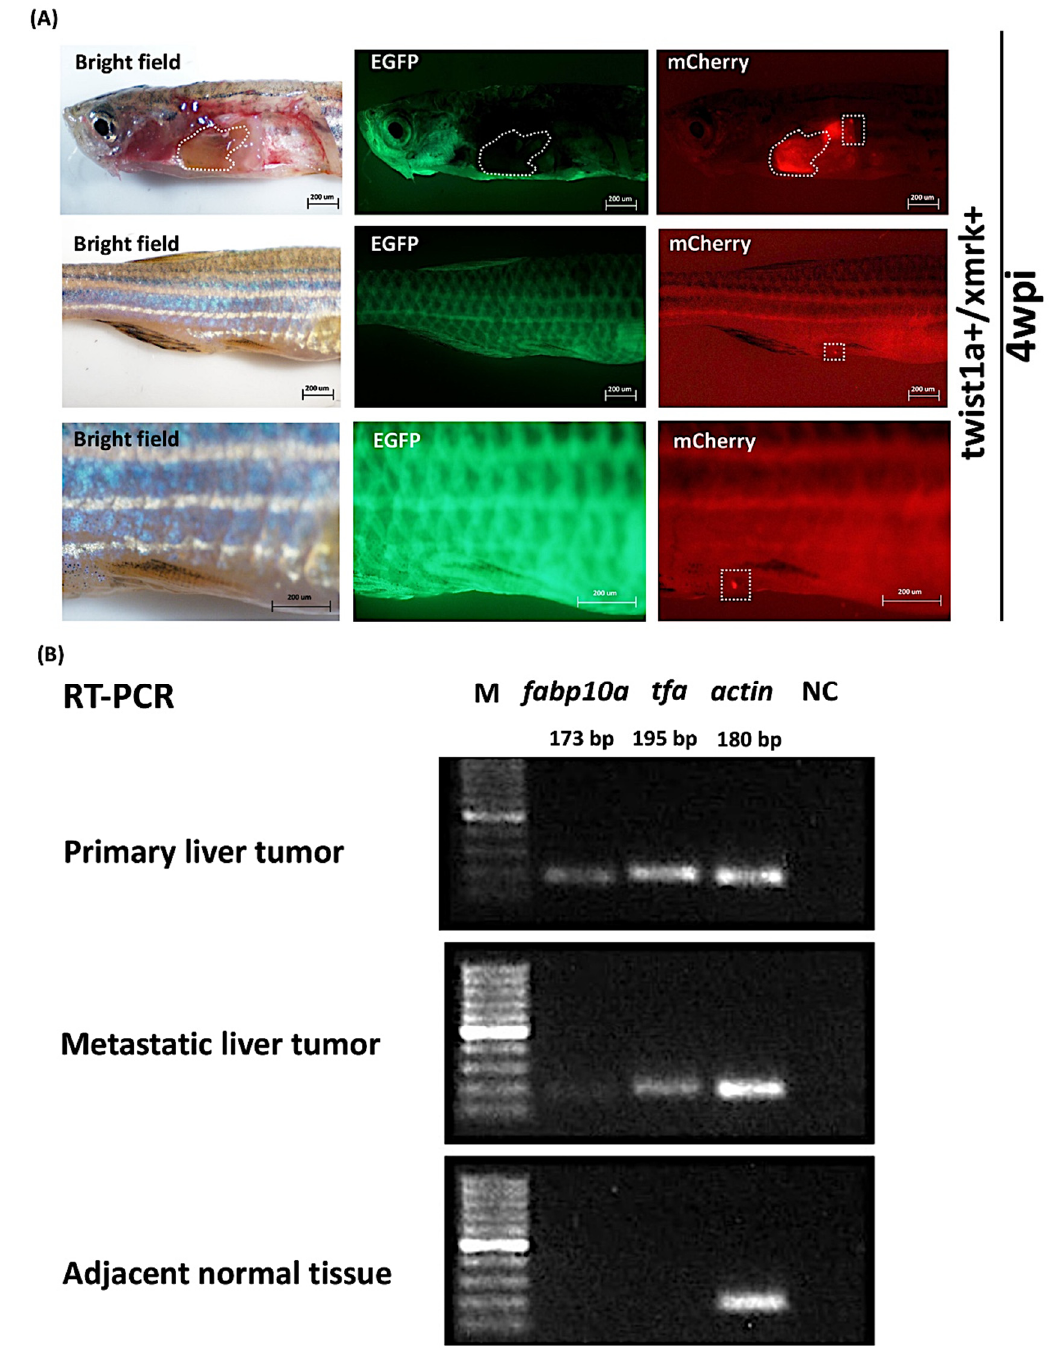
Figure 3. Expression of liver markers fabp10a and tfa in primary and metastatic liver tumor tissues from twist1a+ / xmrk+ double transgenic zebrafish. Twist1a+ / xmrk+ transgenic zebrafish were treated with 60 µ g/mL Dox and 1 µ g/mL 4-OHT. ( A ) mCherry immunofluorescence analysis of twist1a +/ xmrk + liver tumor metastasis at 4 wpi. Scale bar: 200 μ m. ( B ) Results of semiquantitative RT-PCR showing the expression of fabp10a and tfa in primary tumor, metastatic liver tumor, and adjacent normal tissues. Actin and non-template, respectively, served as an internal control and negative control.